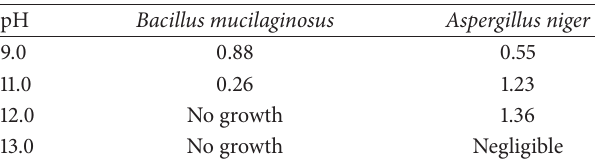
Table 1: Biomass dry weight concentration (g/L) after 96 hours as a function of initial pH during the growth of Bacillus mucilaginosus in nutrient broth medium and of Aspergillus niger in potato dextrose broth medium. pH Bacillus mucilaginosus Aspergillus niger 9.0 0.88